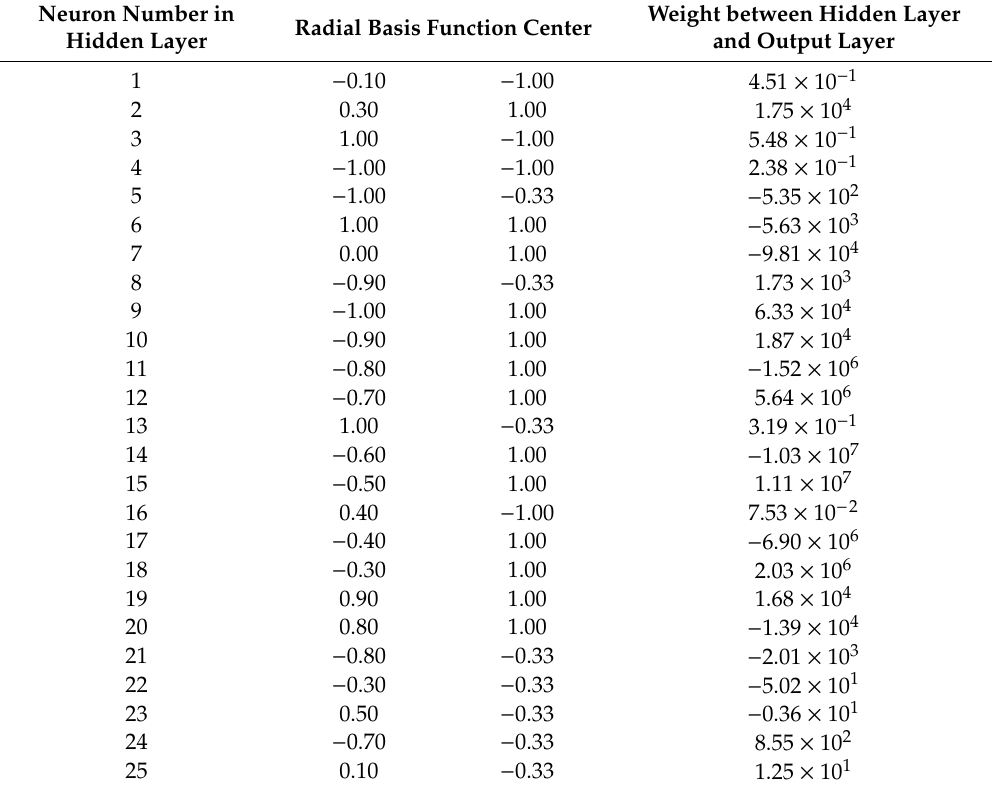
Table 2. Parameters of radial basis function (RBF) neural network model for actuation function degradation